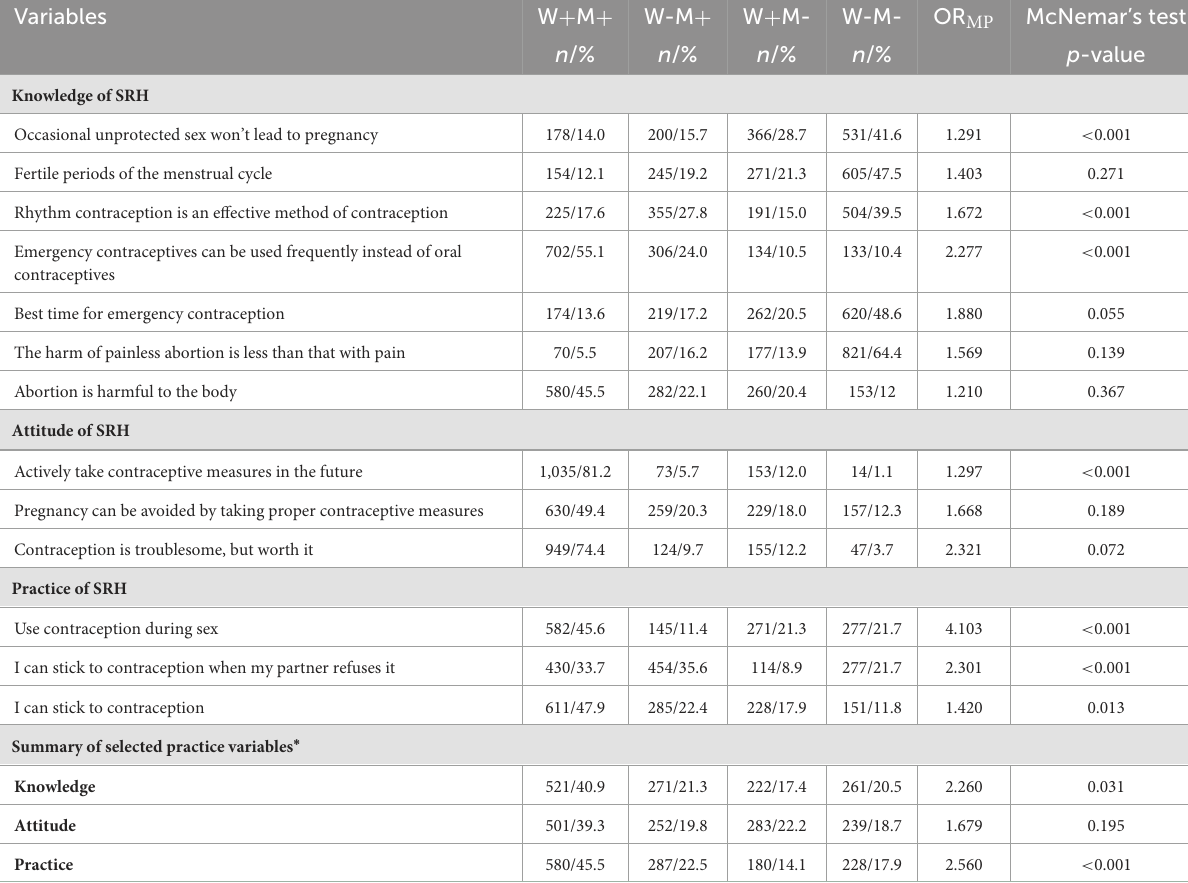
TABLE 4 Partner concordance for KAP of SRH, and comparisons among different patterns ( n = 1,275